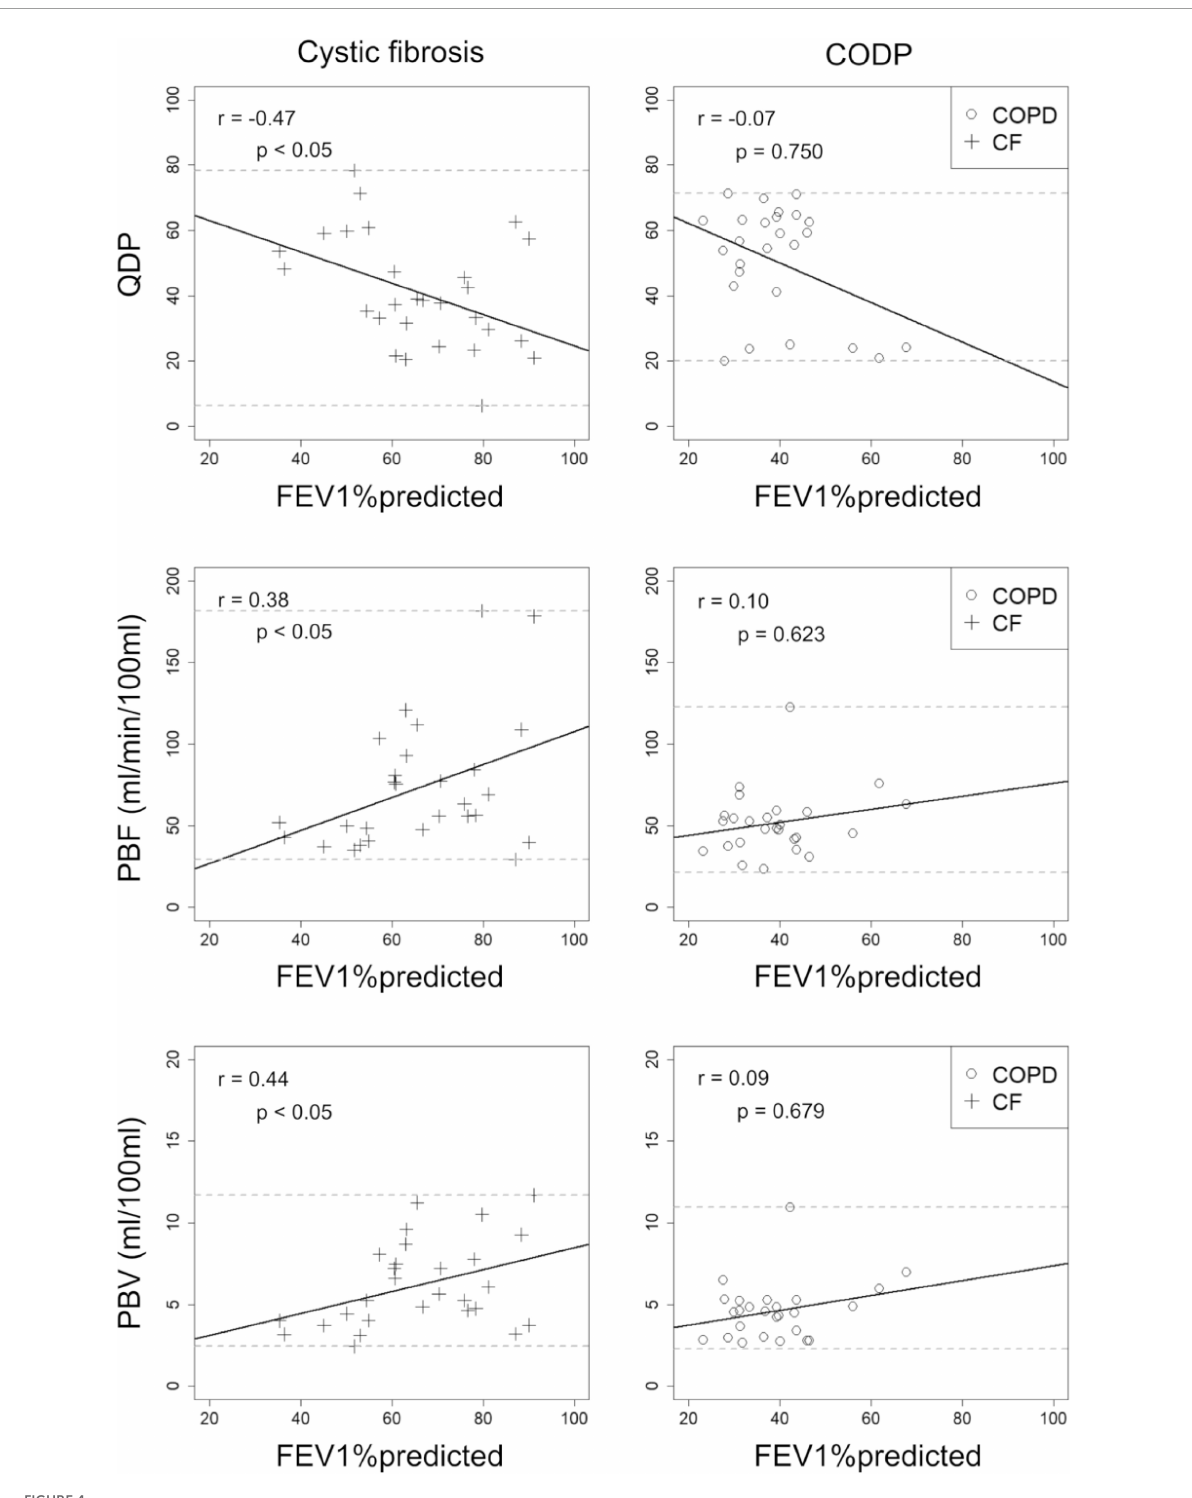
FIGURE4 Correlations between visual MRI perfusion score, perfusion defect percent (QDP), pulmonary blood flow (PBF) and pulmonary blood volume (PBV) with forced expiratory volume in 1s percent predicted (FEV1%predicted) in 13 cystic fibrosis (CF, crosses) and post-bronchodilator FEV1%predicted in 14 chronic obstructive pulmonary disease (COPD, circles) patients. MRI1 and MRI2 were combined. Spearman’s r correlation coefficients and corresponding p -values are given in each panel. Solid lines indicate the linear regression lines, dashed lines the minimum and maximum observed value of the parameter on the